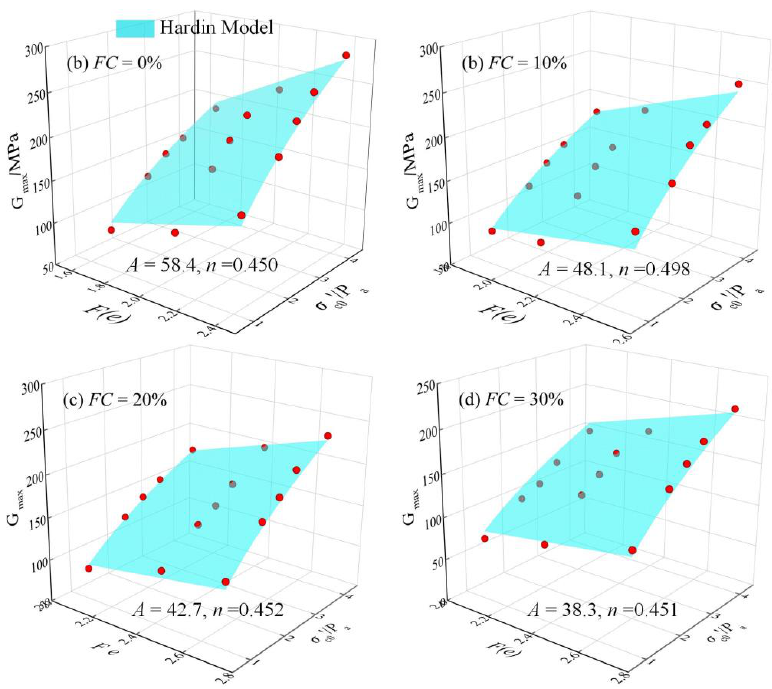
/ P = 0%; a space: ( a ) FC c0